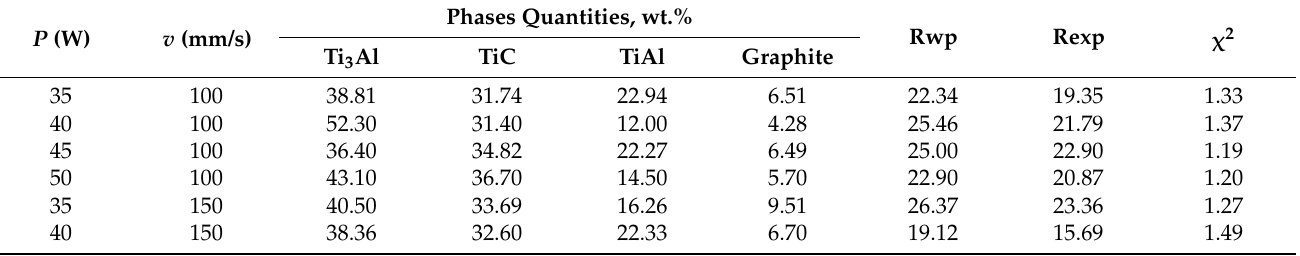
Table 2. Phases quantities of each phase in the ISLF sample, corresponding to different process parameters. Phases Quantities, P (W) v (mm/s)